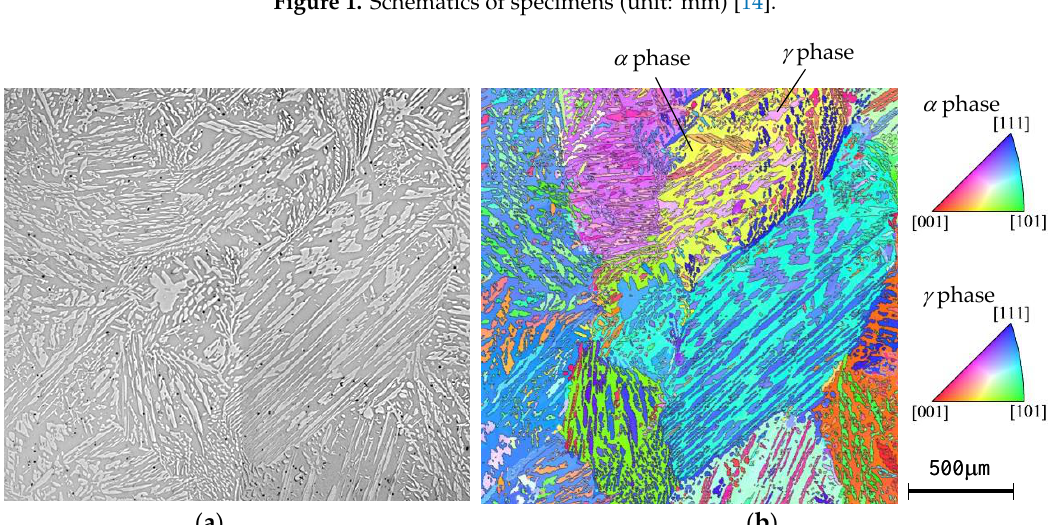
Figure 2. Microstructure of centrifugally cast DSS ASTM A890 Gr.3A. ( a ) Optical microscopy, ( b ) Inverse pole figure (IPF) image.